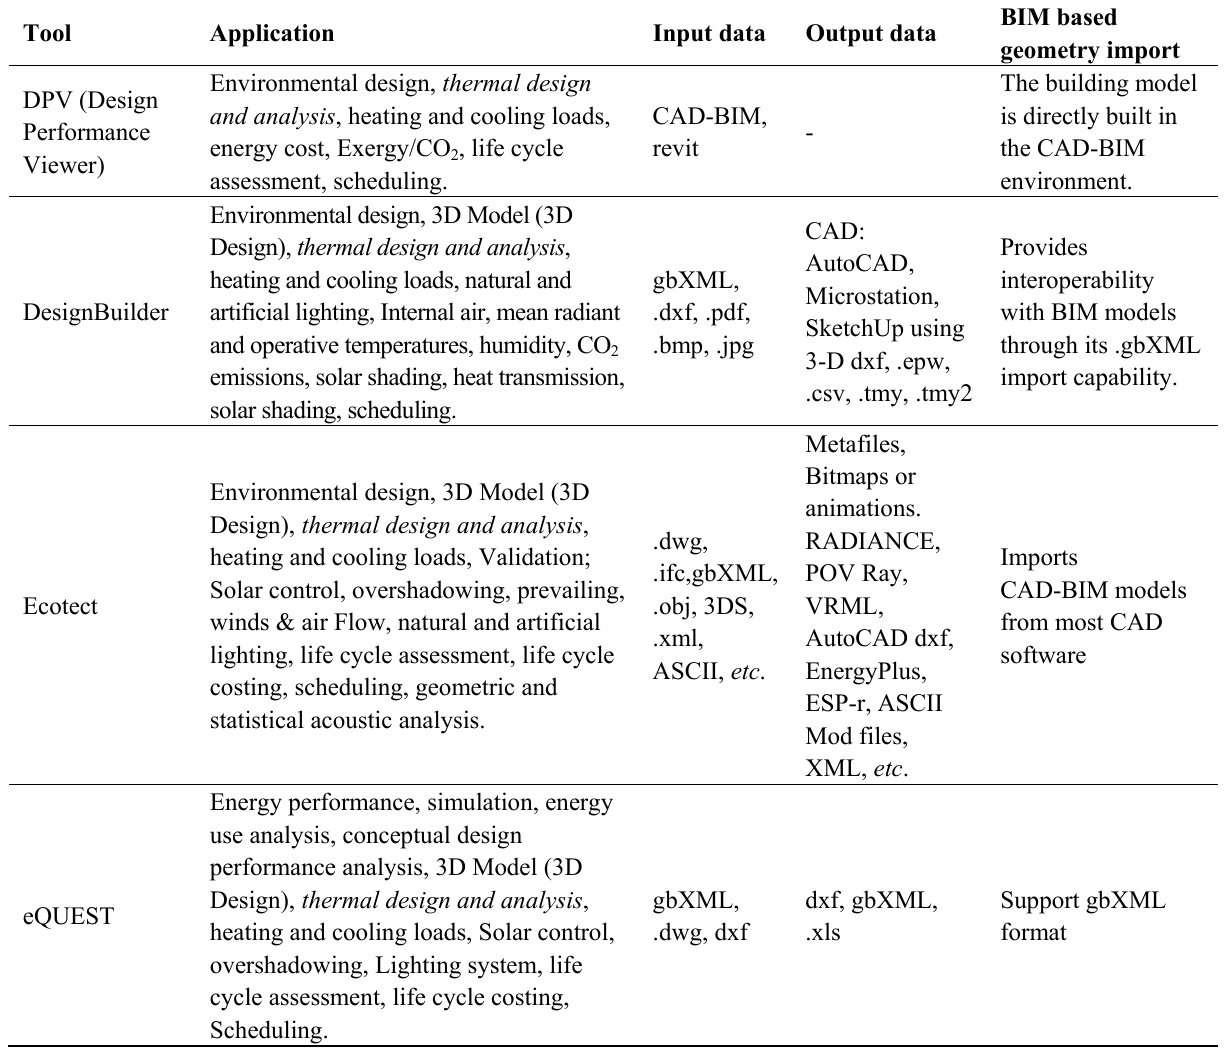
Table 1. Interoperability of the thermal tools